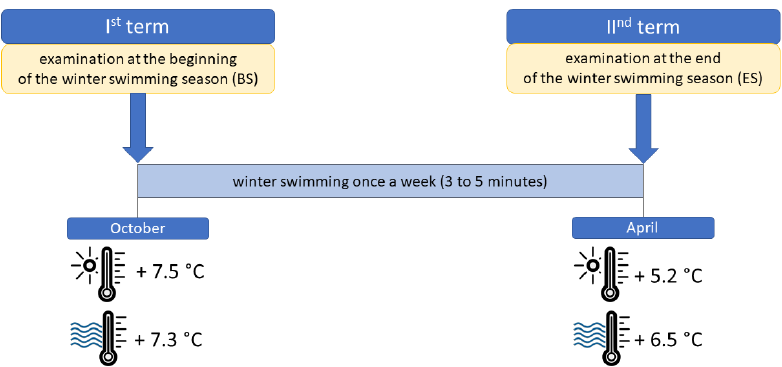
Figure 1. The schedule of material collection and the air and water temperature on the research days.